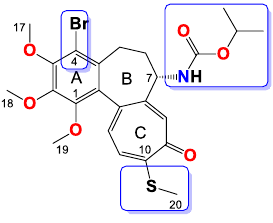
Figure 10. Structure of compound 10 .